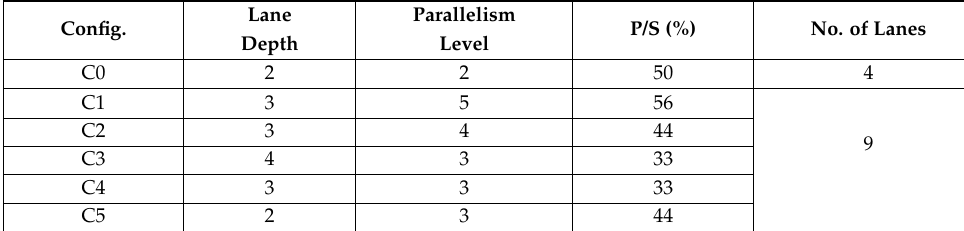
Table 2. R-NoC configurations (P/S denotes the ratio of primary over secondary lanes).